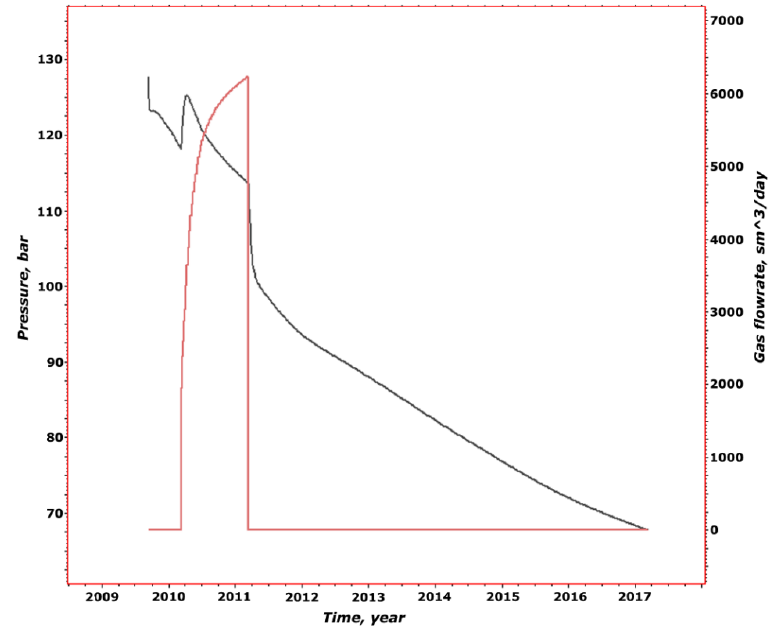
Figure 7. Changes of average pressure in the CO 2 injection zone (black line) and daily CO 2 injection flowrate (red line).